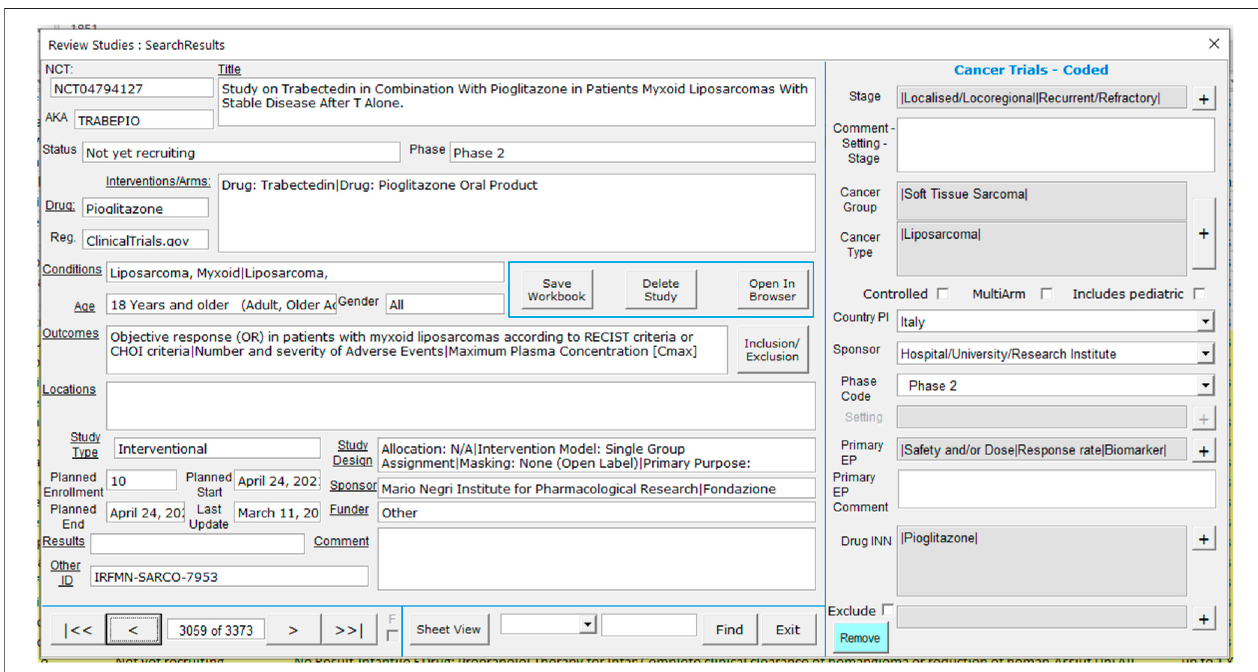
FIGURE 1 | ReDO_Trials_DB coding screen.